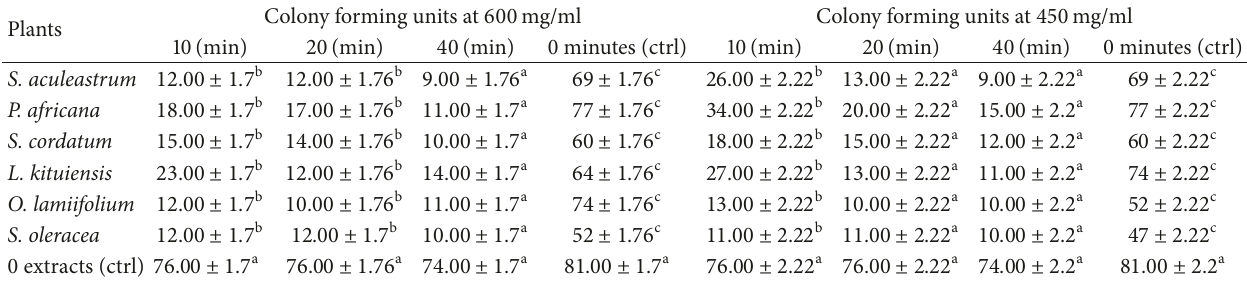
Table 6: Effect of organic plant extracts and photosensitization on Aspergillus flavus UONV003. Colony forming units at 600 mg/ml Plants